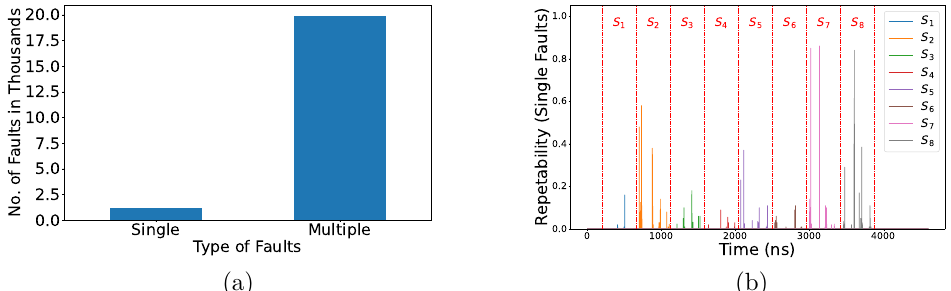
Figure 6: (a) Distribution of no. of faulted entries of the Sbox - Single vs Multiple Faults (b) Repeatability of single faults on the distinct Sboxes of 3DES over